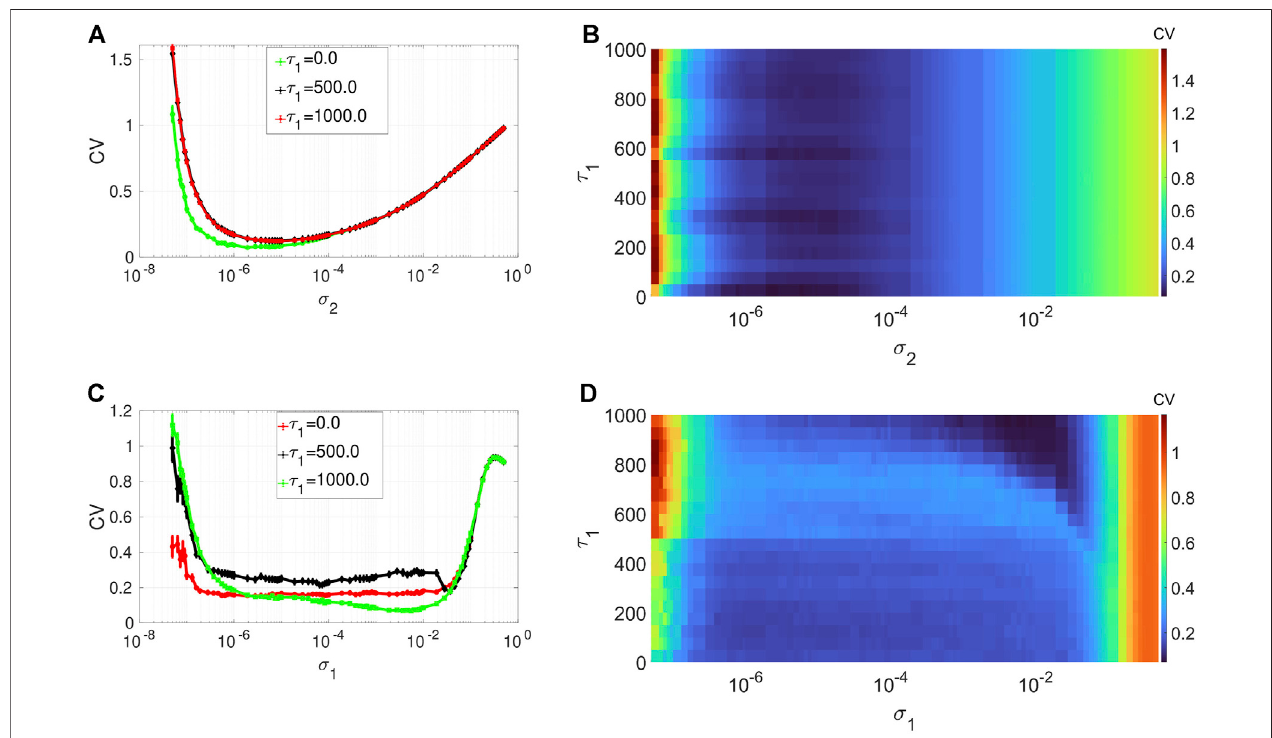
FIGURE 4 | Variation of CV w.r.t. the time delay τ 1 and noise intensity σ 1 for SISR or σ 2 for CR. Panels (A) and (B) show the CV curves due to CR ( σ 1 = 0, ε 1 = 0.01, 〈 s 〉 =2).Panels (C) and (D) showtheCVcurvesduetoSISR( σ 1 20, D 1 = 0.5, τ 1 p = 20, N =